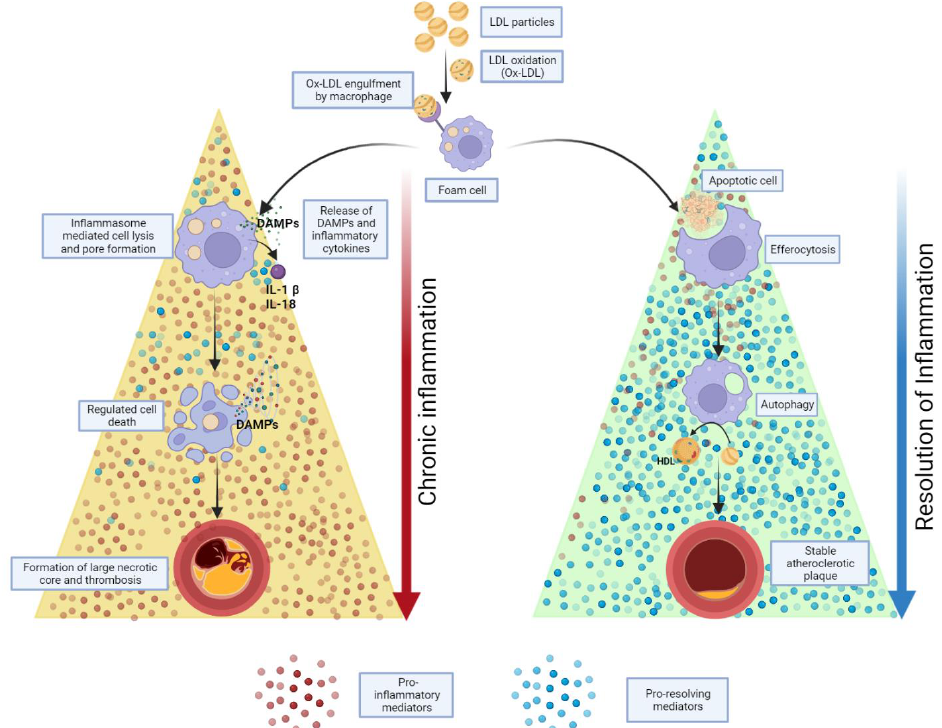
Figure 1. The proportion of pro-inflammatory and pro-resolving mediators in its microenvironment decides the stability and fate of a growing plaque. An abundance of pro-inflammatory mediators, results in inflammasome mediated pore formation leading to inflamed cell death and further release of proinflammatory mediators such as DAMPs, prolonging the inflammation cycle and rendering the plaque unstable and prone to thrombus formation. On the contrary, with an abundance of SPMs in the milieu leads to efferocytosis, a non-phlogistic clearance of any cellular debris, and regulated autophagy leading to a stable plaque.